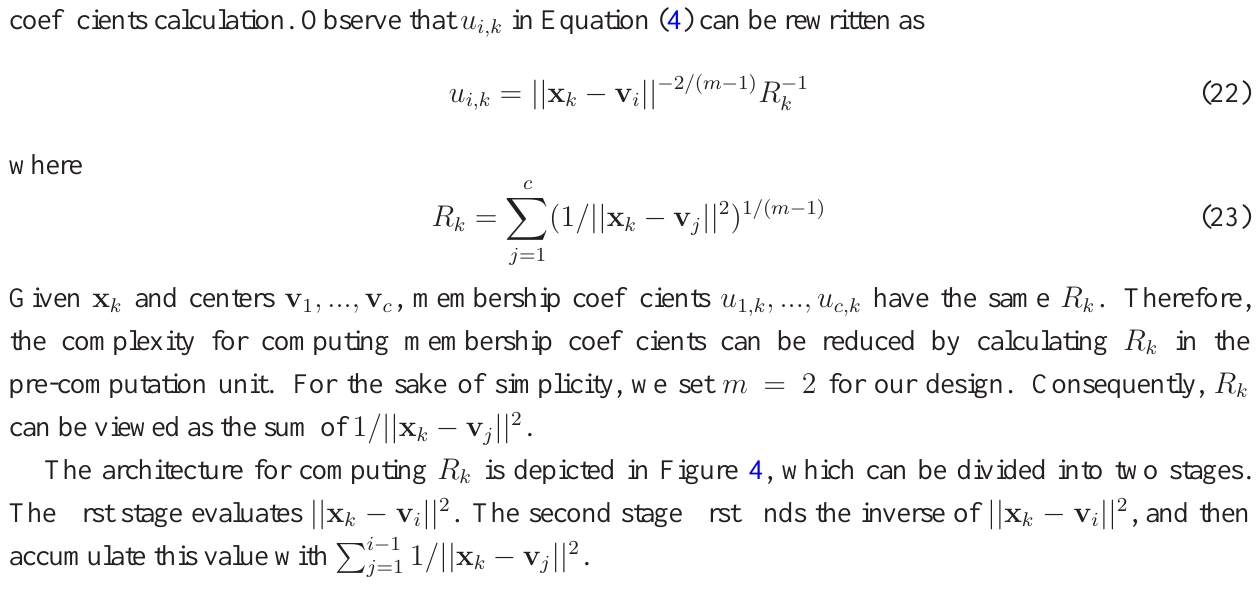
Figure 4. The architecture of pre-computation